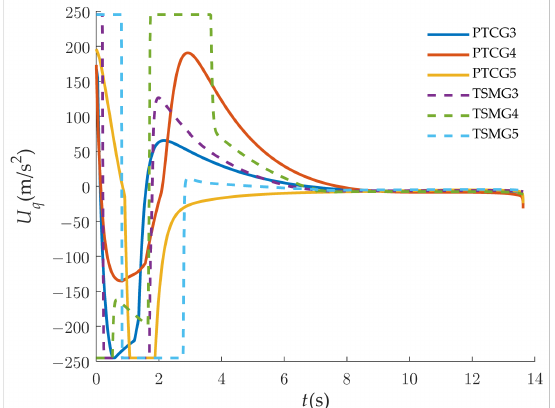
Figure 14. Attack-angle comparison between PTCG and TSMG.